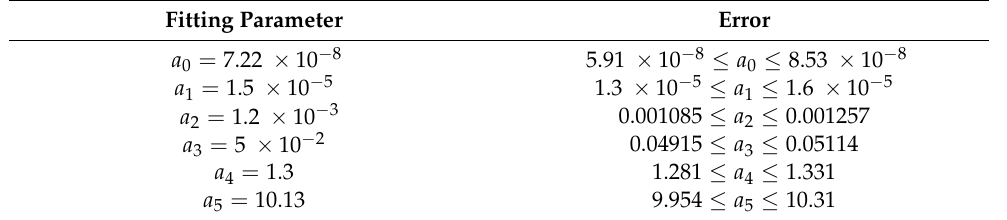
Figure 17. The desired and fitted trajectories. Table 6. Fitting parameters and errors.